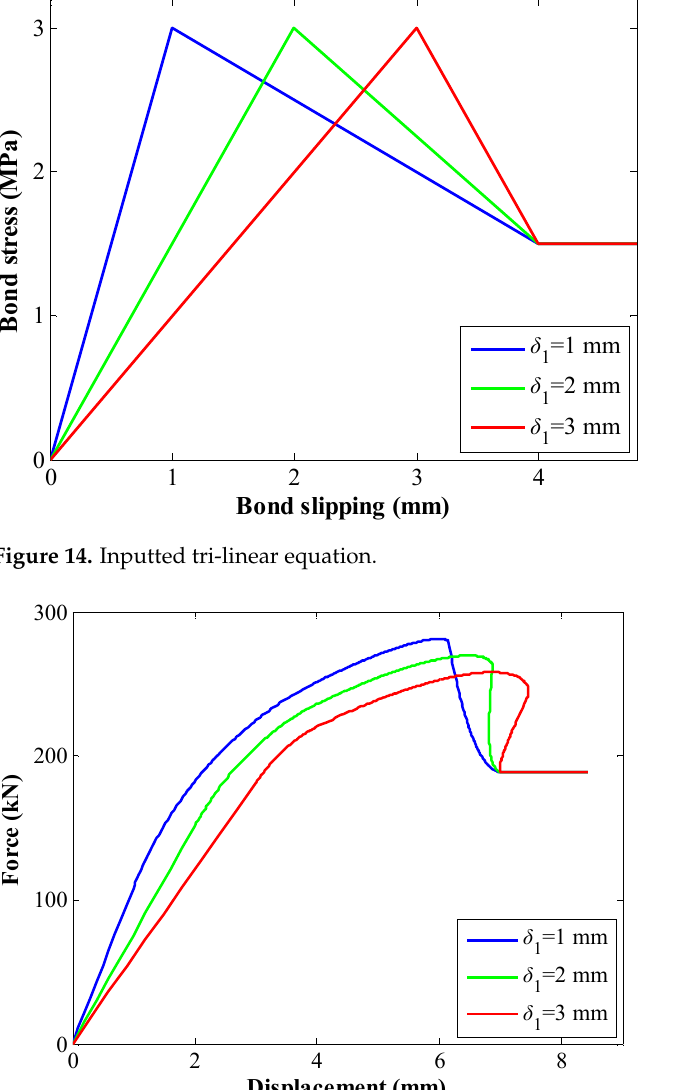
Figure 14. Inputted tri-linear equation.